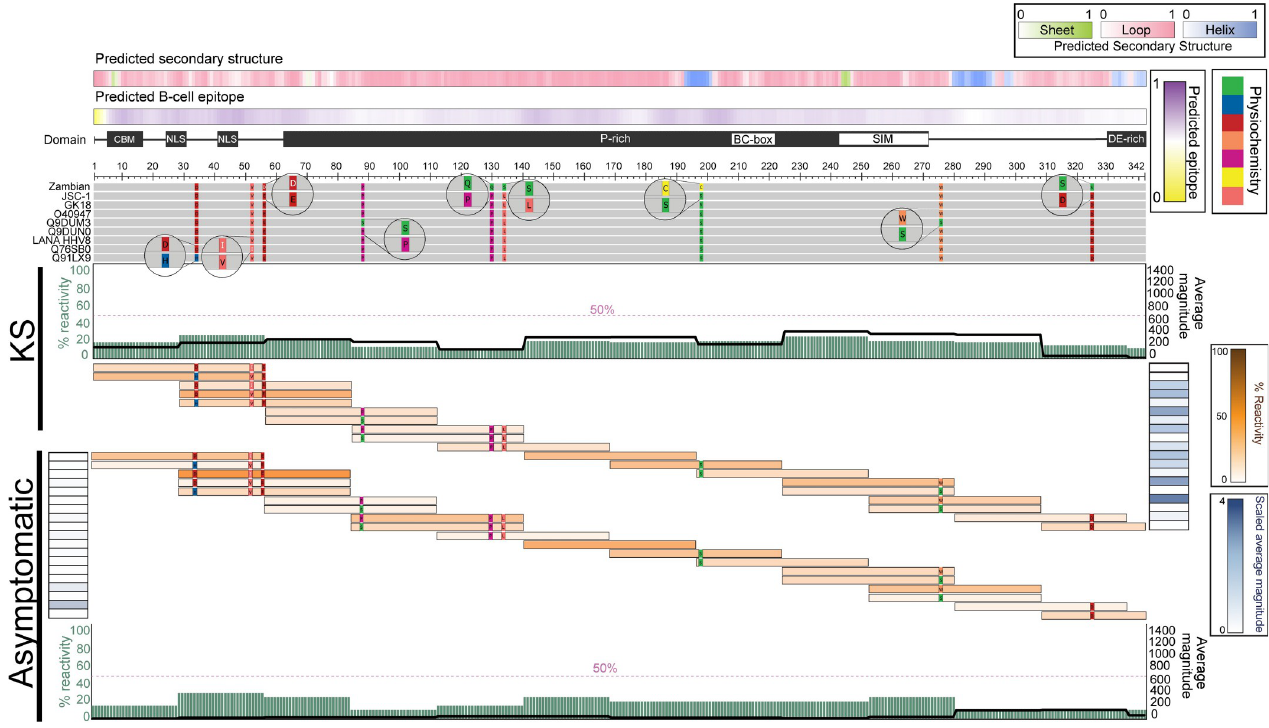
Fig 4. KSHV-LANA N-terminus epitope mapping in KS and asymptomatic individuals. The multiple sequence alignment (MSA) of reference sequences followed by the input library sequences is shown where gray represents conservation among the sequences. Mismatched residues are colored by their physiochemical properties as defined by the Zappo color scheme (green: hydrophilic, salmon: aliphatic/aromatic, orange: aromatic, fuchsia: conformationally special, yellow: cysteine only, red: negatively charged, blue: positively charged). Predicted secondary structures are represented in color gradients representing the probabilities (minimum [0; white] and maximum [1; sheet (green), loop (pink), or helix (blue)]). BepiPred-2.0 scores representing predicted B-cell epitope probabilities, along with functional motifs/domains are annotated directly above the aligned sequences. In addition, each peptide that was targeted by at least one individual was mapped and colored based on the percent cohort reactivity (brown gradient). Adjacent to the peptide responses of each group, scaled average magnitudes are shown in blue gradient. Moreover, percent patient reactivity and average magnitude of responses are calculated at the amino-acid level, represented by the sage bars and black lines in each group, respectively. CBM : Chromosome binding motif , NLS : Nuclear localization sequence , P-rich : Proline- rich region , BC-box : associated to Elongin B/C motif , SIM : Small ubiquitin-related modifier (SUMO) Interacting motif , DE-rich : Aspartic/Glutamic acid-rich region